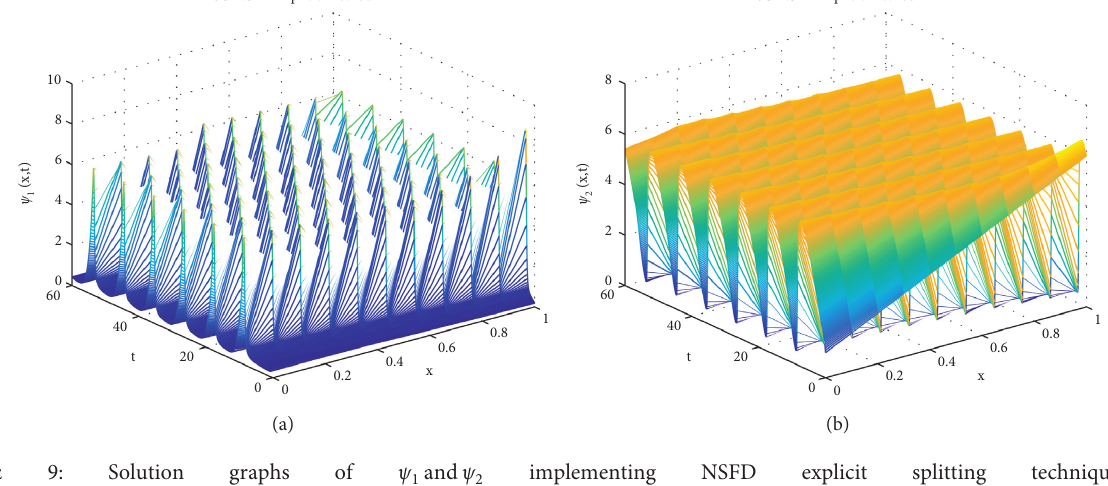
Solution graphs of ψ